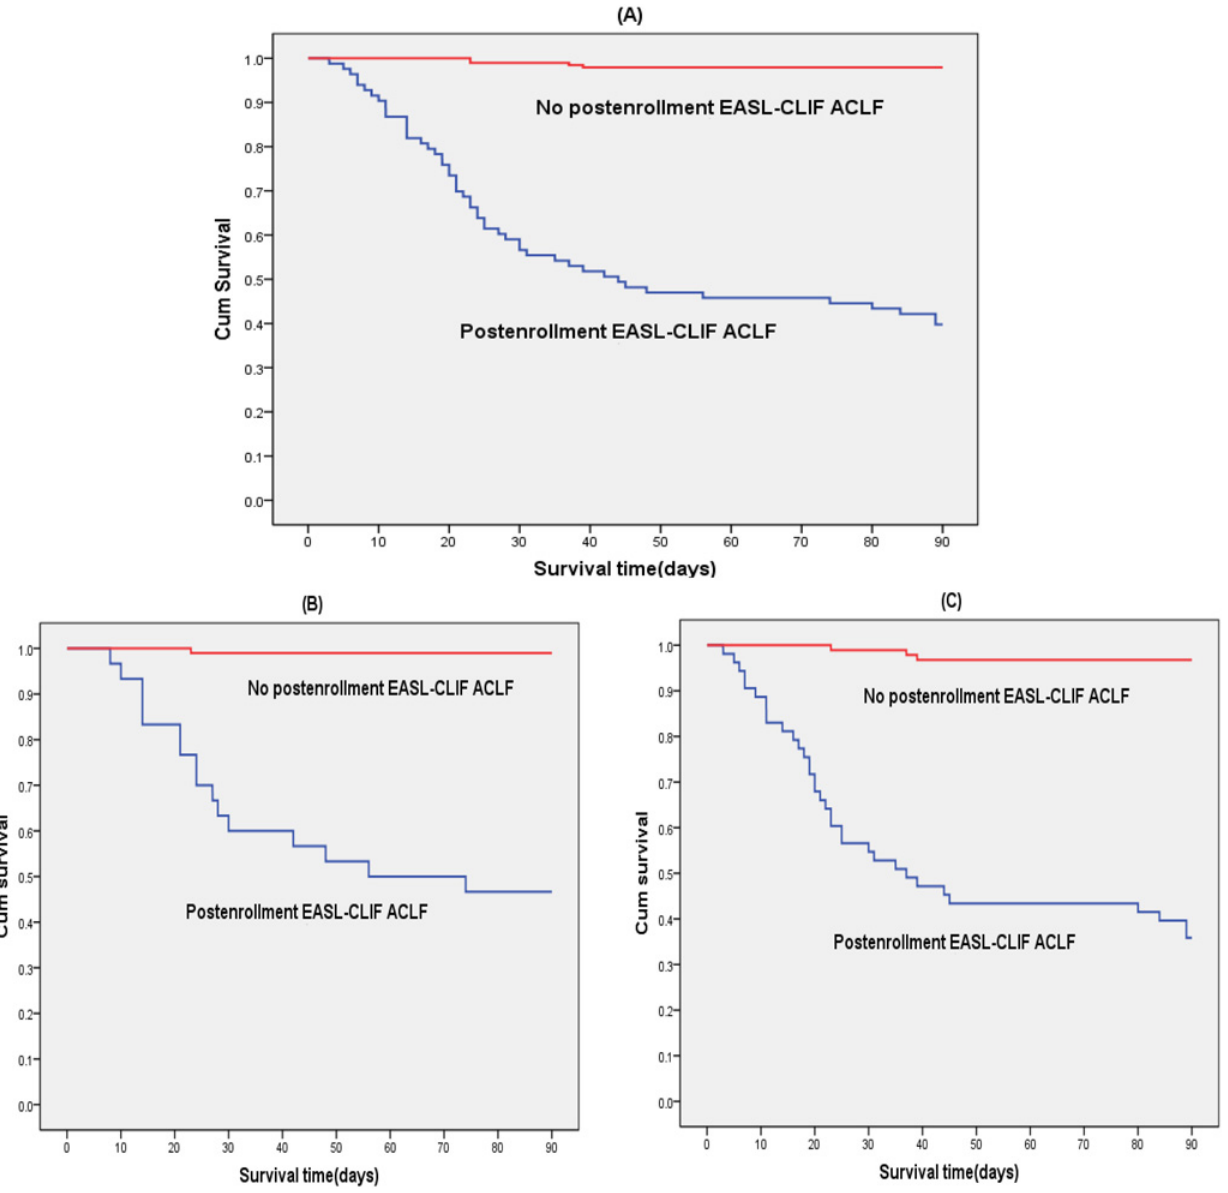
Fig 3. Comparison of survival between patients with and without progression to post-enrollment EASL-CLIF ACLF. Patients with ACLF at enrollment defined by APASL criteria alone were classified into group A, while patients with ACLF at enrollment defined by both APASL and CMA criteria but not EASL- CLIF criteria were classified into group B. Among the entire 276 patients in groups A and B, patients with progression to post-enrollment EASL-CLIF ACLF had a significantly lower survival than those without (log-rank test: P < 0.001) (A). Among patients in either group A (B) or group B (C), significantly lower survival was also observed in patients with progression to post-enrollment EASL-CLIF ACLF than those without (log-rank test: P < 0.001). Abbreviations: ACLF, acute-on-chronic liver failure; EASL-CLIF, EASL-Chronic Liver Failure.